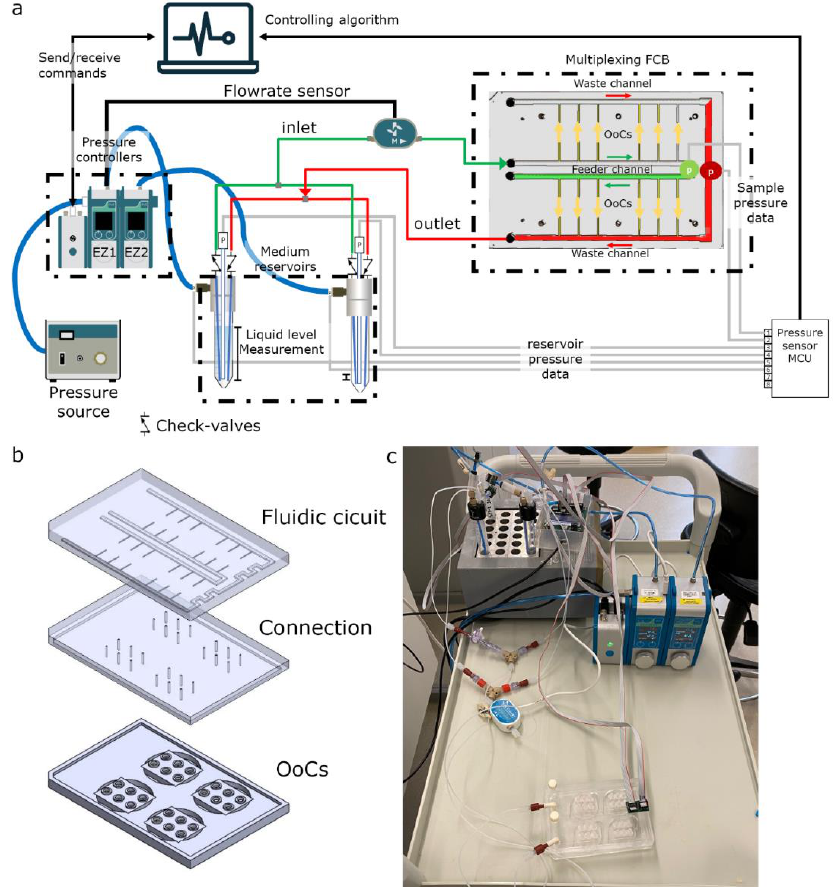
Figure 1. Overview of the perfusion system ( a ) Schematic of the microfluidic circuit consisting of 2 pressure controllers connected to a pressure source, additional pressure sensors (p), a passively controlled recirculation circuit and a custom-made fluidic circuit board to multiplex the perfusion to multiple samples. ( b ) Exploded view of the FCB shows the fluidic circuit, connection layer and 4 OoC-devices. ( c ) Photograph of the system